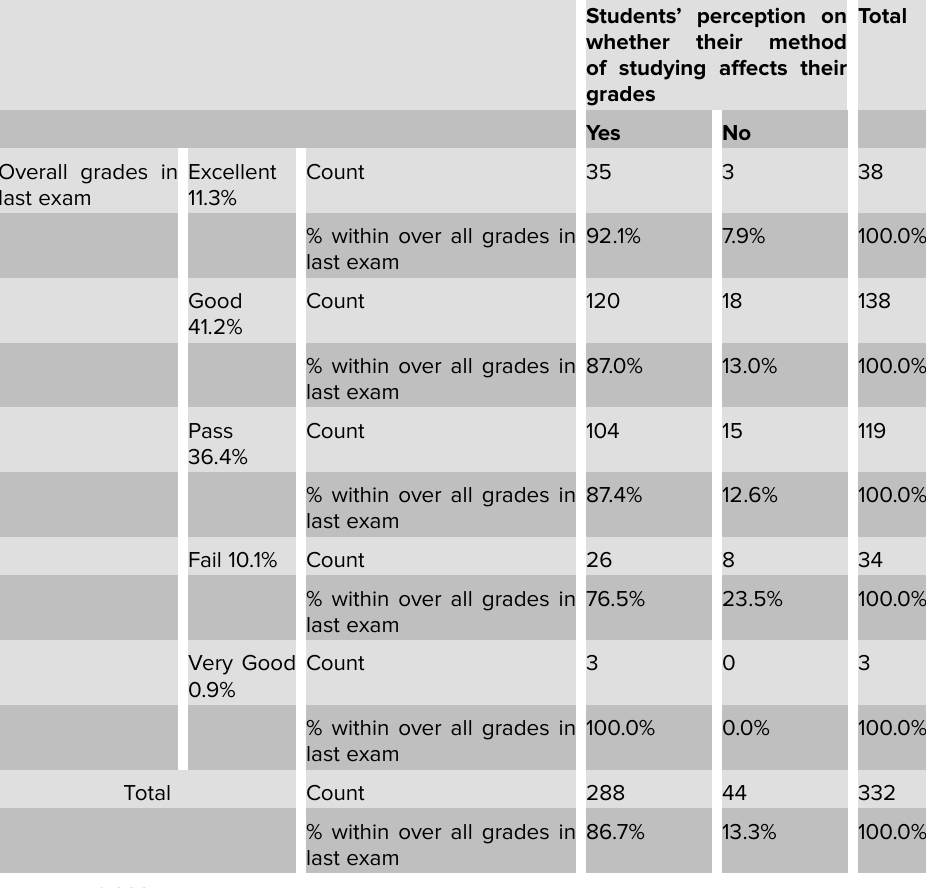
Table 3: Students’ perception on whether their method of study affects their grades. Students’ perception